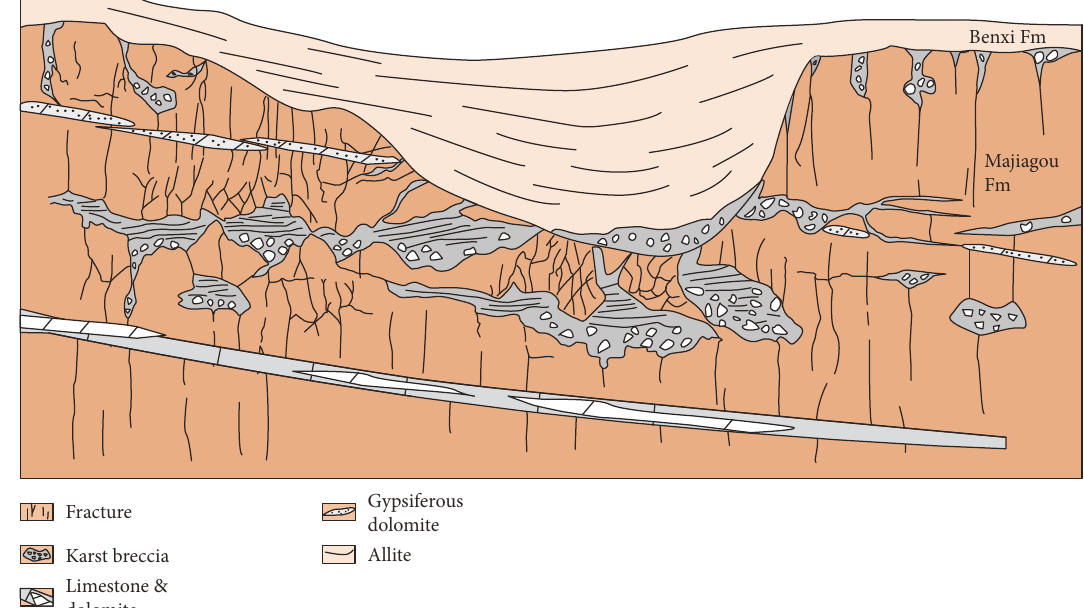
Figure 9: Characteristics of the Ordovician carbonate karstic reservoirs in Ordos Basin. The karst reservoir model was modi fi ed from reference